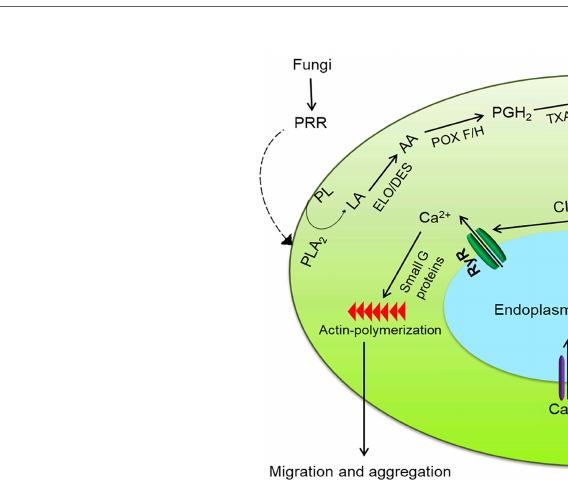
FIGURE 9 | Intracellular immune signaling in S. exigua hemocytes following fungal infection. Fungal hyphae or conidia are recognized by pattern recognition receptor ( ‘ PRR ’ ), which activates the Toll pathway to increase PLA 2 activity. The activated PLA 2 releases linoleic acid ( ‘ LA ’ ), which is desaturated and elongated into arachidonic acid ( ‘ AA ’ ). AA is then oxygenated by two peroxinectins ( ‘ POX F/H ’ ) into PGH 2 , which is isomerized into TXA 2 /TXB 2 by TXA 2 synthase ( ‘ TXAS ’ ). TXA 2 /TXB 2 is transferred out of the cell to bind with its GPCR ( ‘ PGE 2 R ’ ) and activate phospholipase C ( ‘ PLC ’ ). PLC increases intracellular inositol triphosphate ( ‘ IP 3 ’ ) concentrations which binds to its receptor ( ‘ IP 3 R ’ ) on endoplasmic reticulum, thereby releasing Ca 2+ into the cytoplasm Ca 2+ triggers calcium-induced calcium release ( ‘ CICR ’ ) from a ryanodine receptor ( ‘ RyR ’ ). The free Ca 2+ is a secondary signal to activate small G proteins for actin polymerization to facilitate hemocyte